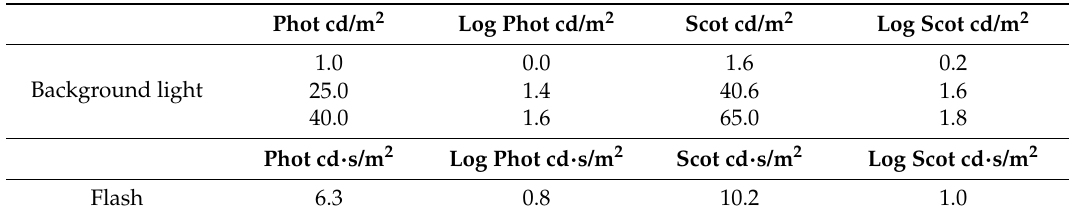
Table 4. Luminances used in the study. Conversion factor from photopic (phot) cd/m 2 to scotopic (scot) cd/m 2 , and from phot cd · s/m 2 to scot cd · s/m 2 is 1.624. Phot cd/m 2 Log Phot cd/m 2 Scot cd/m 2 Log Scot cd/m 2 1.0 Background light